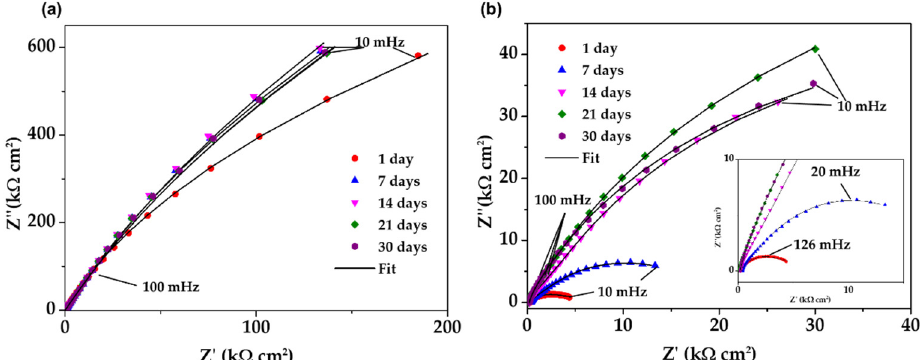
Figure 7. EIS Nyquist diagrams with a respective fitting line for SS430 and carbon steel B450C after different times of immersion in cement extract solutions: ( a ) SS430 and ( b ) B450C in SS1 solution.